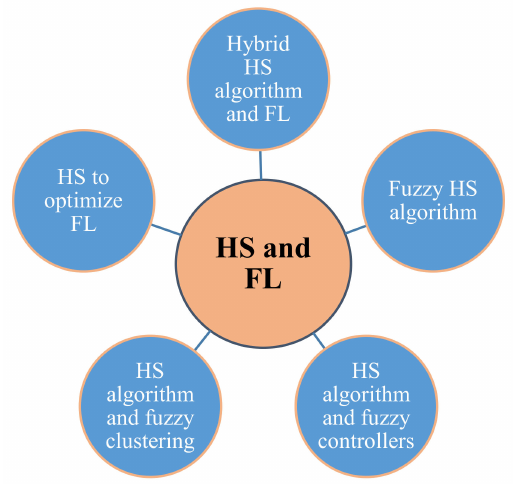
Figure 4. Different categories of papers based on the HS and